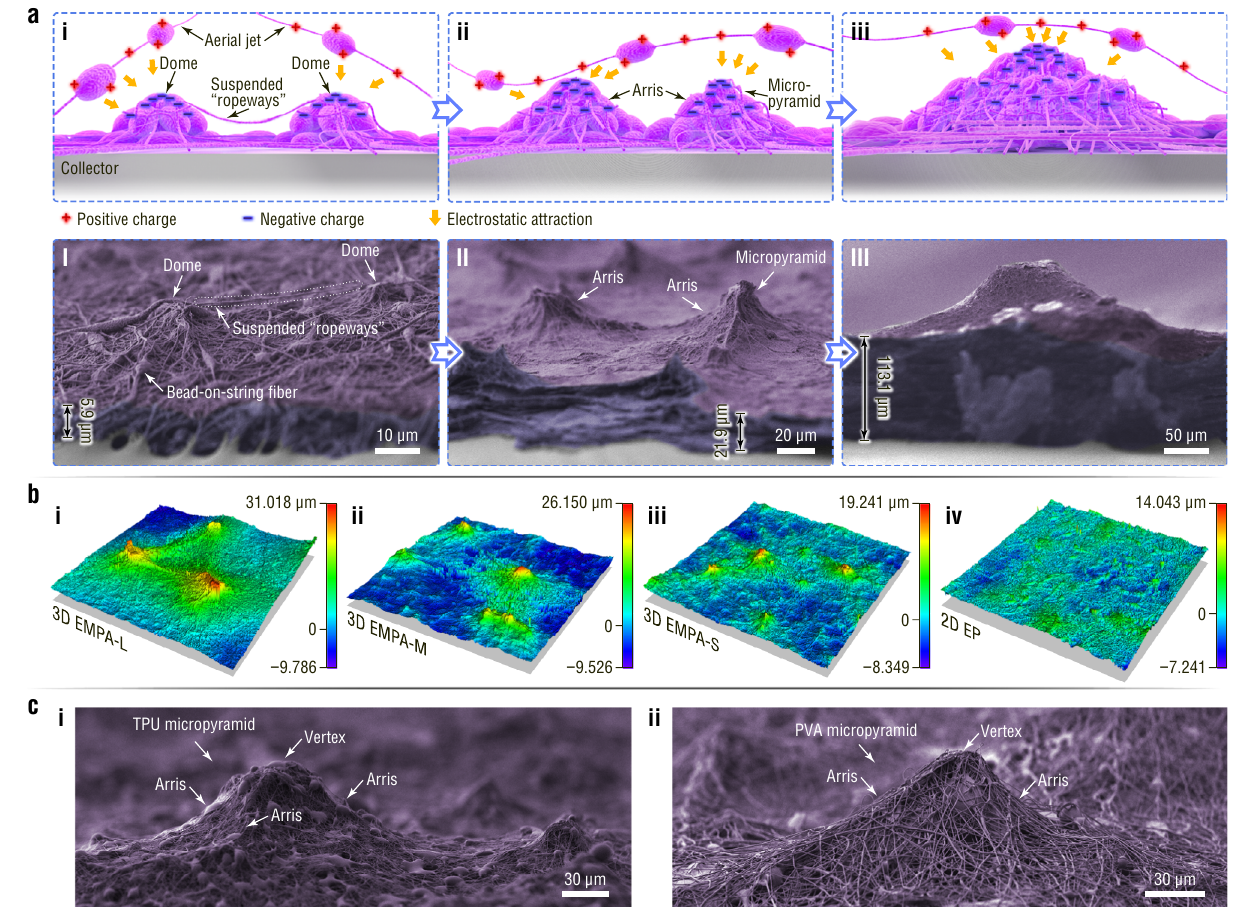
Fig. 2 | Growth process and structural and material designability of EMPAs. a Schematic illustration and SEM images showing the growth process of EMPAs. b LCM images of EMPA-based fi lms with average pyramid heights of (i) 24.75, (ii)